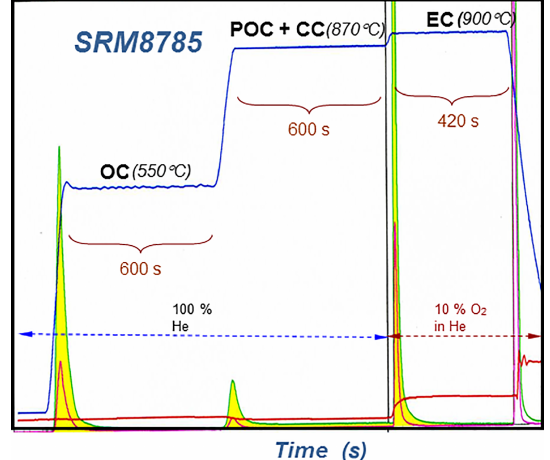
Figure 4. Typical thermograph of the NIST standard (SRM8785: urban dust on filter) using the thermal method (EnCan-total-900). The solid dark blue line indicates the temperature time series. The green and red peaks highlighted in yellow are two flame ionization detector signals (one with higher sensitivity than the other). The solid red line is the laser transmittance; however, it is not relevant here since transmittance is not used to determine the OC and EC concentration. The determinations of the OC, POC + CC, and EC mass fractions are purely based on temperature and retention